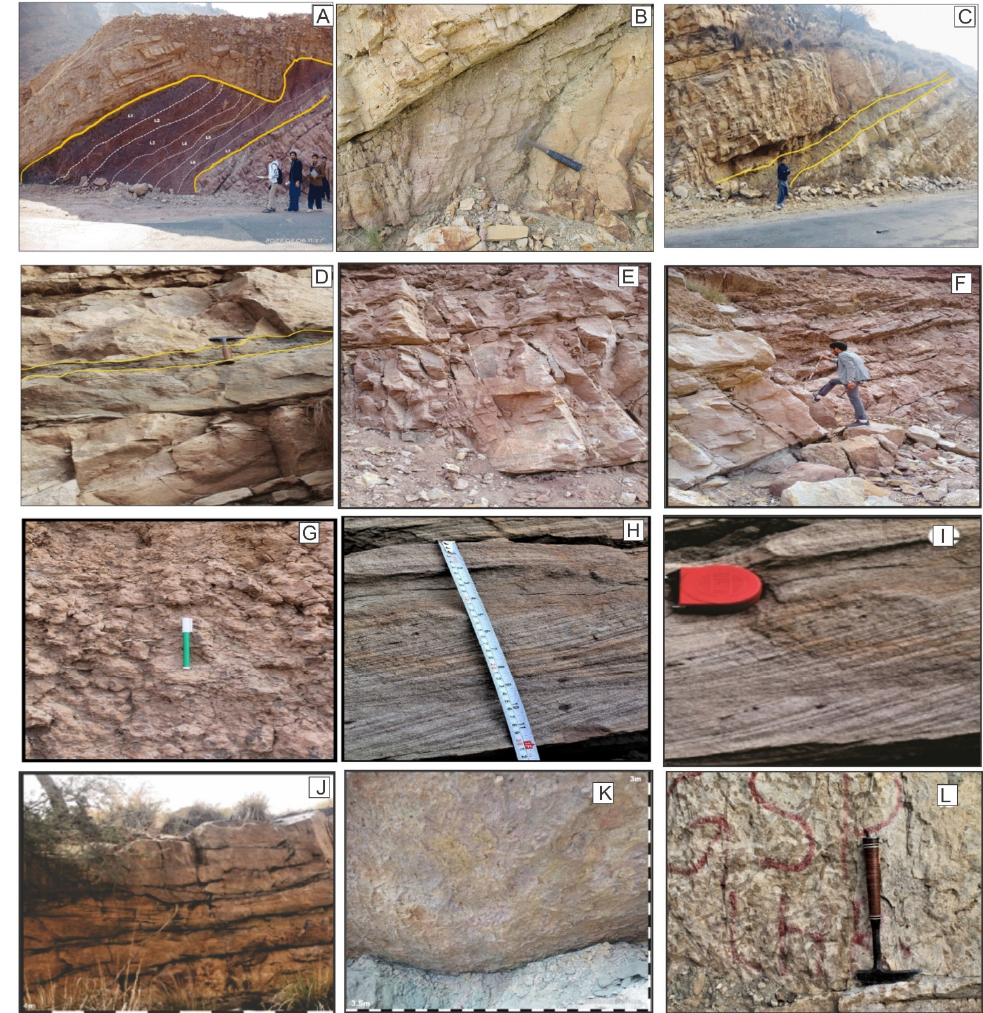
Figure 4. ( A ) Paleosol unit in the Pab Formation and their different colors variation; ( B ) field photo- graph showing the channelized sandstone unit in Pab Formation; ( C ) very fine-grained claystone unit; ( D ) shale unit interbedded in sandstone; ( E ) and ( F ) massive bedding sandstone unit; ( G ) nodules in sandstone; ( H ) and ( I ) planar cross-bedded sandstone; ( J ) large-scale trough cross-bedded sandstone; and ( K ) and ( L ) trace fossils and bioturbation in Pab